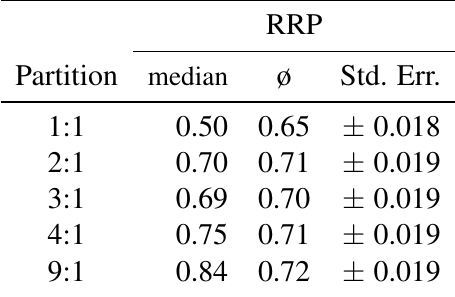
Table 2: RRP of different partition